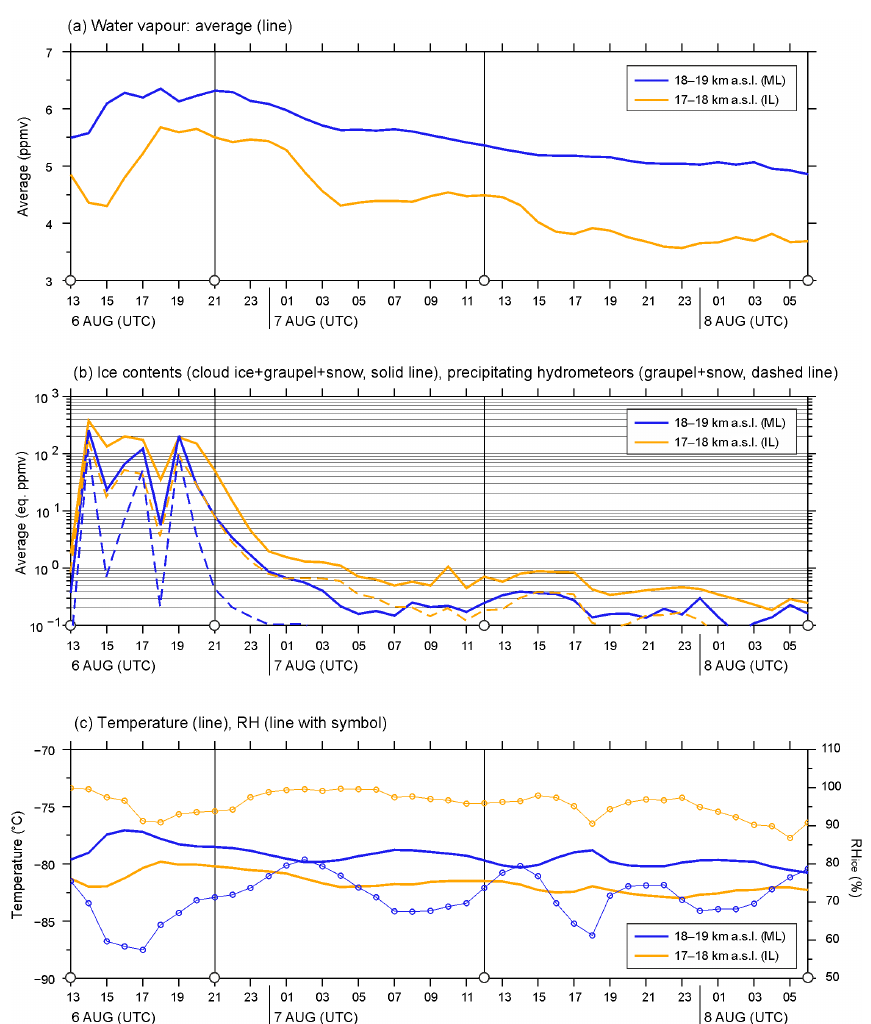
Figure 10. Hourly evolution of (a) averaged water vapour (line), (b) averaged ice content (solid line; sum of ice, graupel, and snow) and the precipitating hydrometeor (dashed line; sum of graupel and snow), and (c) averaged temperature (line) and relative humidity (RH ice ; thin line with circle) in the altitudes of 17–18km (yellow lines) and 18–19km (blue lines) from 13:00UTC on 6 August to 06:00UTC on 8 August 2017. The four analysis times are marked by open circles on the x axis. Average and maximum values are calculated in the ML and